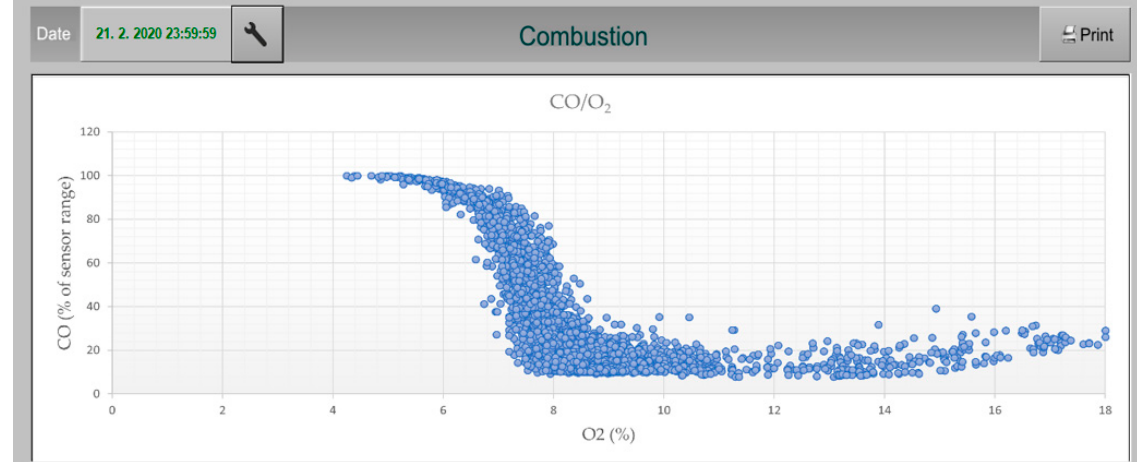
Figure 6. An example of online evaluation of the CO emissions dependence on O 2 concentration in the flue gas.